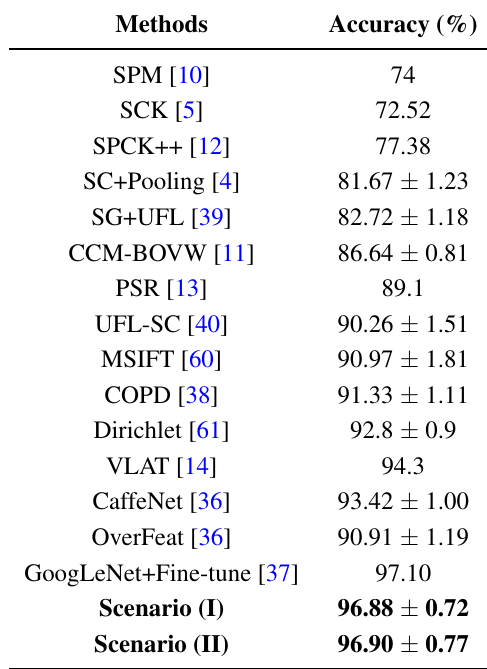
Table 7. Performance Comparison of State-of-the-art Methods on the UCM